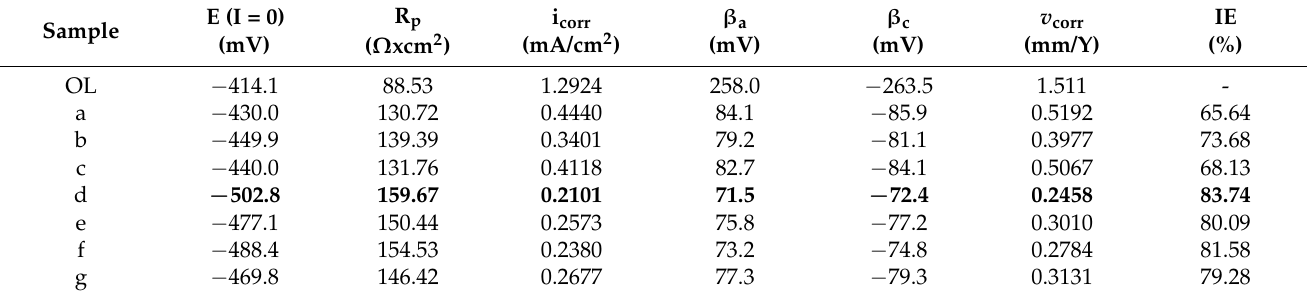
Table 2. The most significant parameters obtained from Tafel curves for protected steel electrodes after immersing them for 30 min in 0.1 M HCl